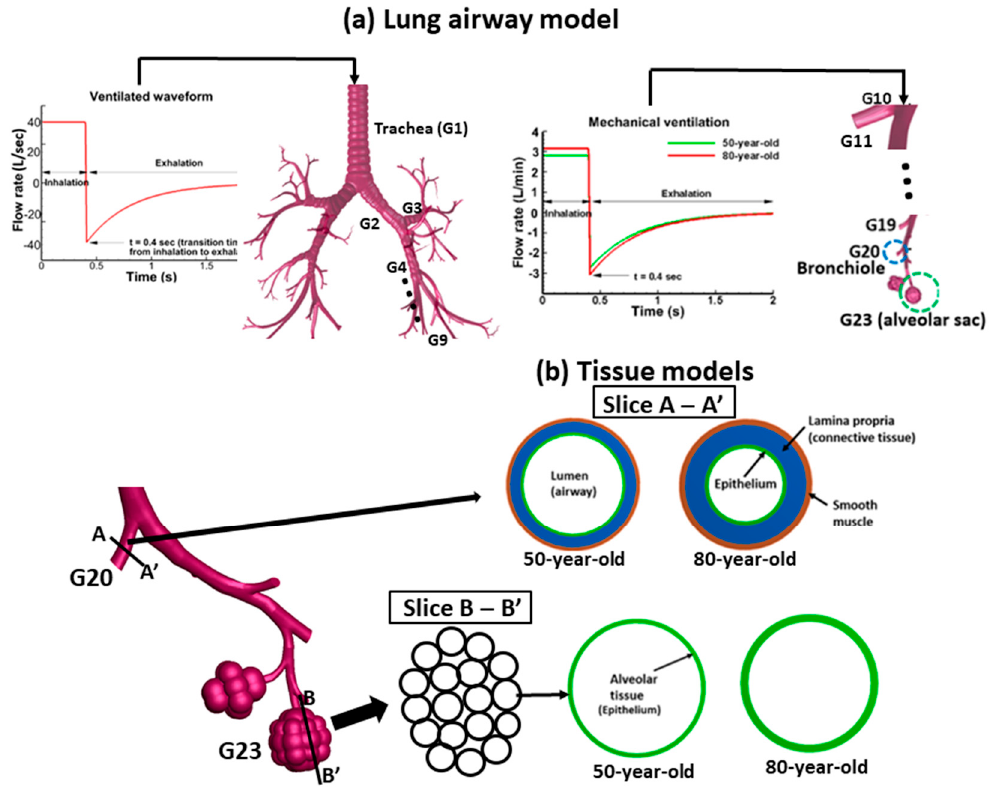
Figure 1. Overview of lung airway model and tissue model: ( a ) lung airways (G10–G23) and the applied waveform at the inlet; ( b ) tissue models of the bronchiole (G20) and the alveolar sac (G23). The lower bifurcation is the region where the aging effect has been considered. The single airway (terminal bronchiole) is connected to the entrance of the alveolar sacs. Each alveolus has an alveolar duct and numerous sacs.